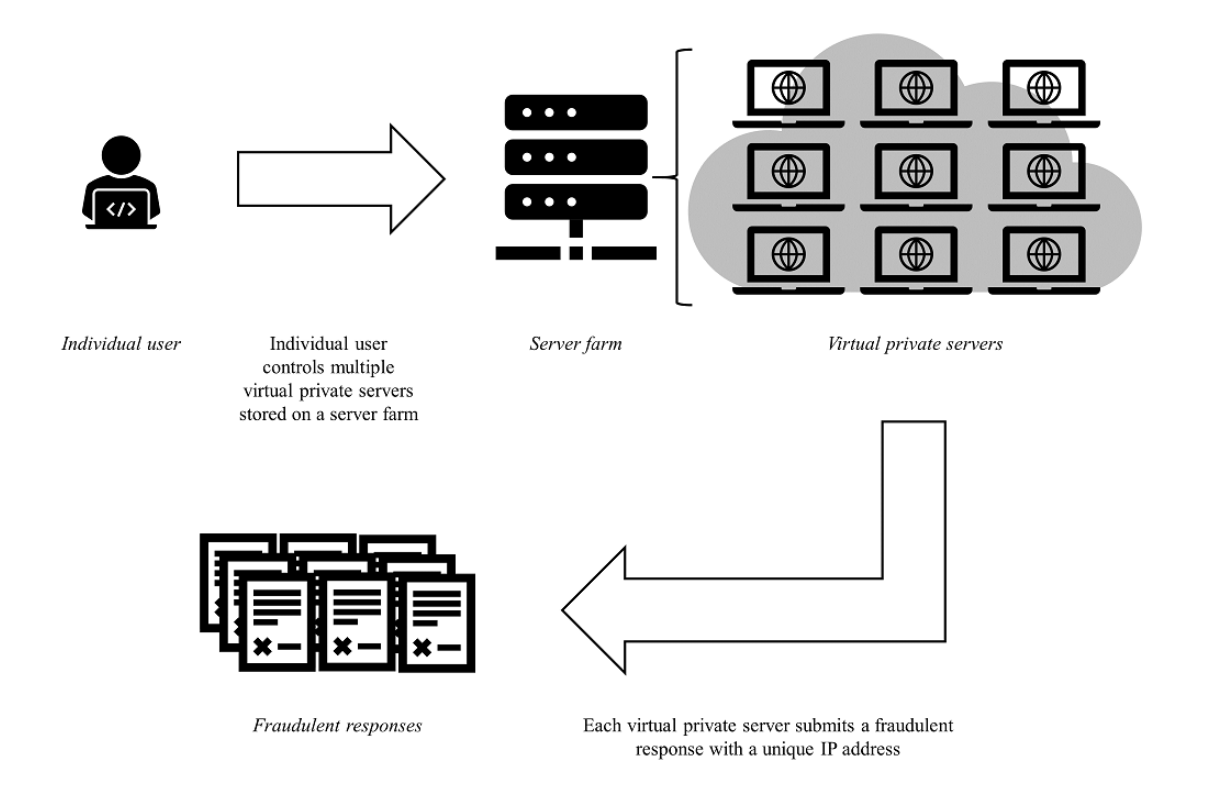
Figure 2. The role of virtual private servers in research participant